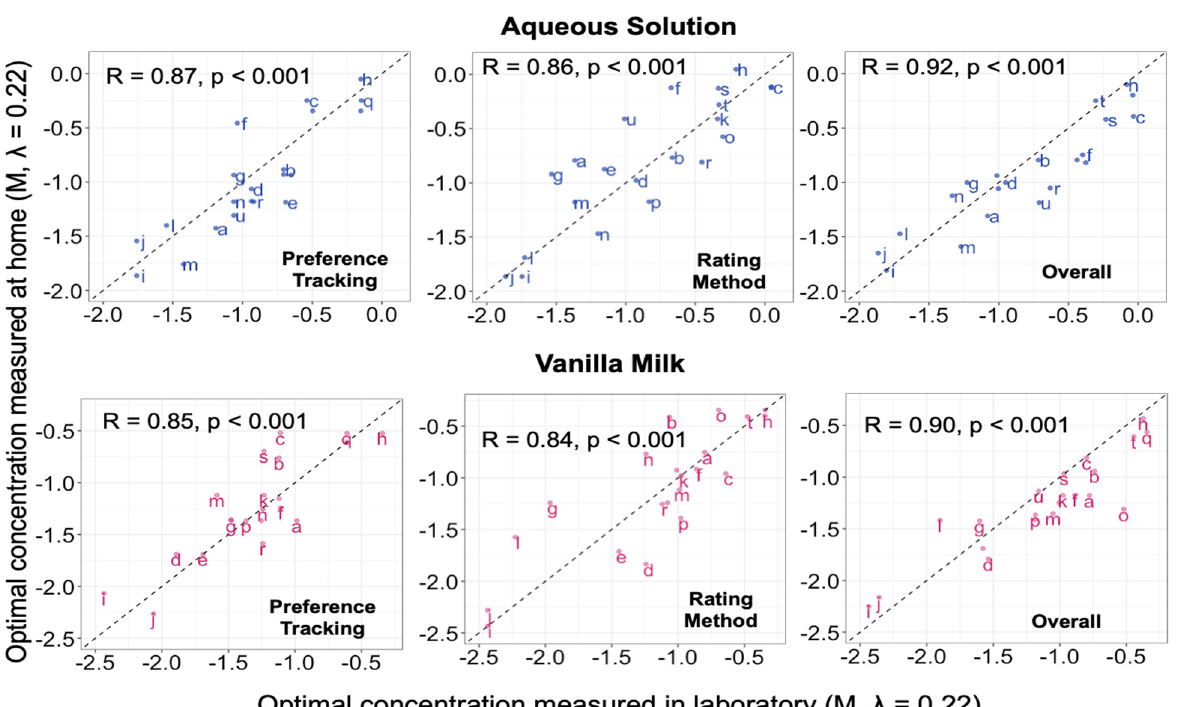
Figure 4. Scatter plots for optimal concentration measured at home (averaged across repeated sessions) vs. optimal concentration measured in the laboratory. Values are Box-Cox transformed ( λ = 0.22) sucrose concentrations (M). The letters on the plot represent participant ID. Top (blue points): optimal concentration estimated using aqueous solutions. Bottom (pink points): optimal concentration estimated using vanilla milk. Left to right: estimated via paired-comparison preference tracking (PT), estimated from ratings of liking (RM), and averaged across the two sensory methods (overall). Dotted line: line of equality (y = x line). Table 2. Results of variance decomposition of hedonically optimal